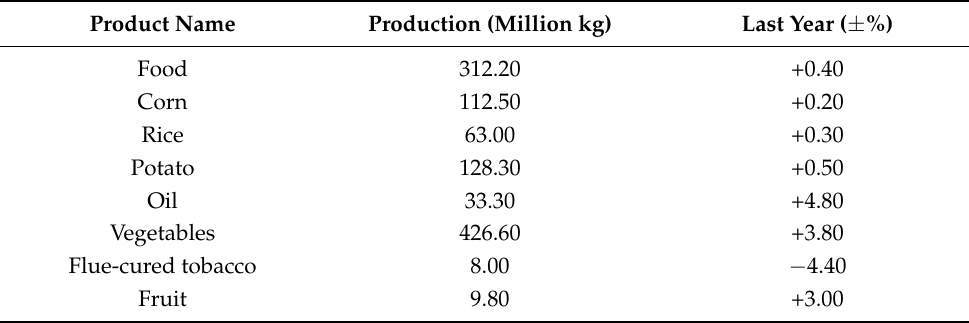
Table 1. The output of major agricultural products in Pengshui County in 2020.